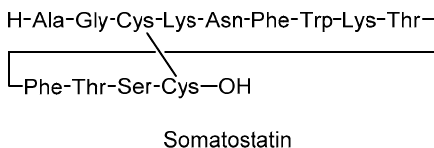
Figure 1. Amino acid sequence of the peptide somatostatin (SST).